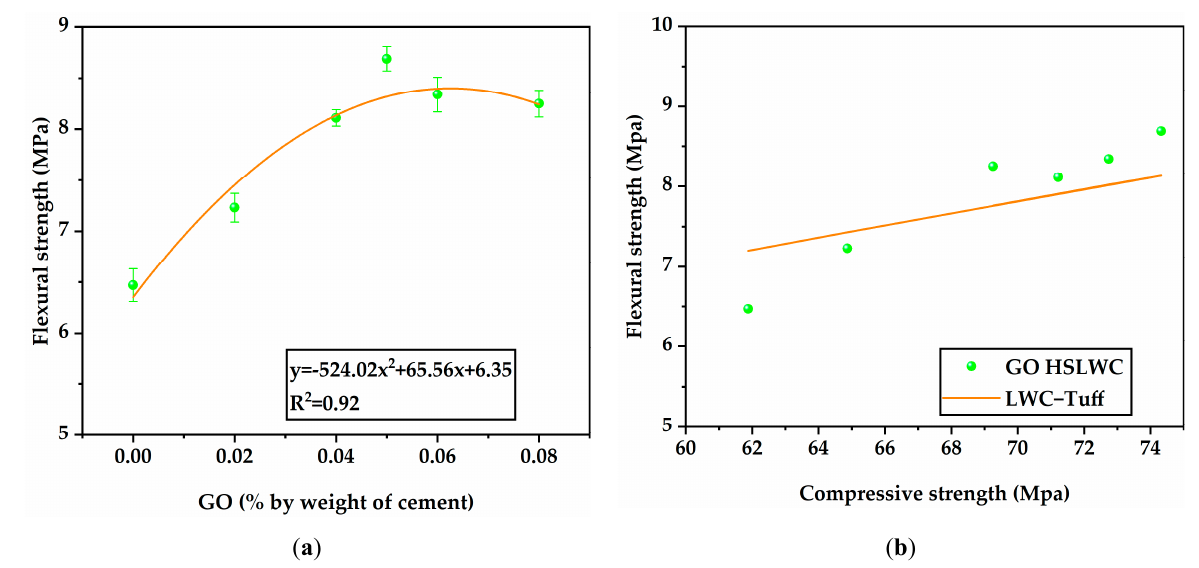
Figure 8. Flexural strength results of HSLWC: ( a ) fl exural strength with di ff erent contents of GO; ( b ) prediction of fl exural strength.